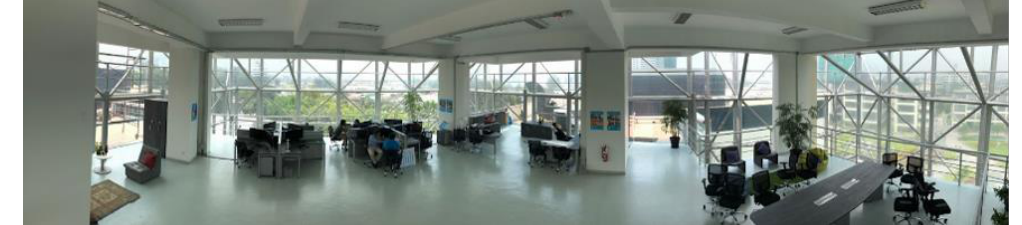
Figure 3. Laboratory of Simulación de Proyectos.